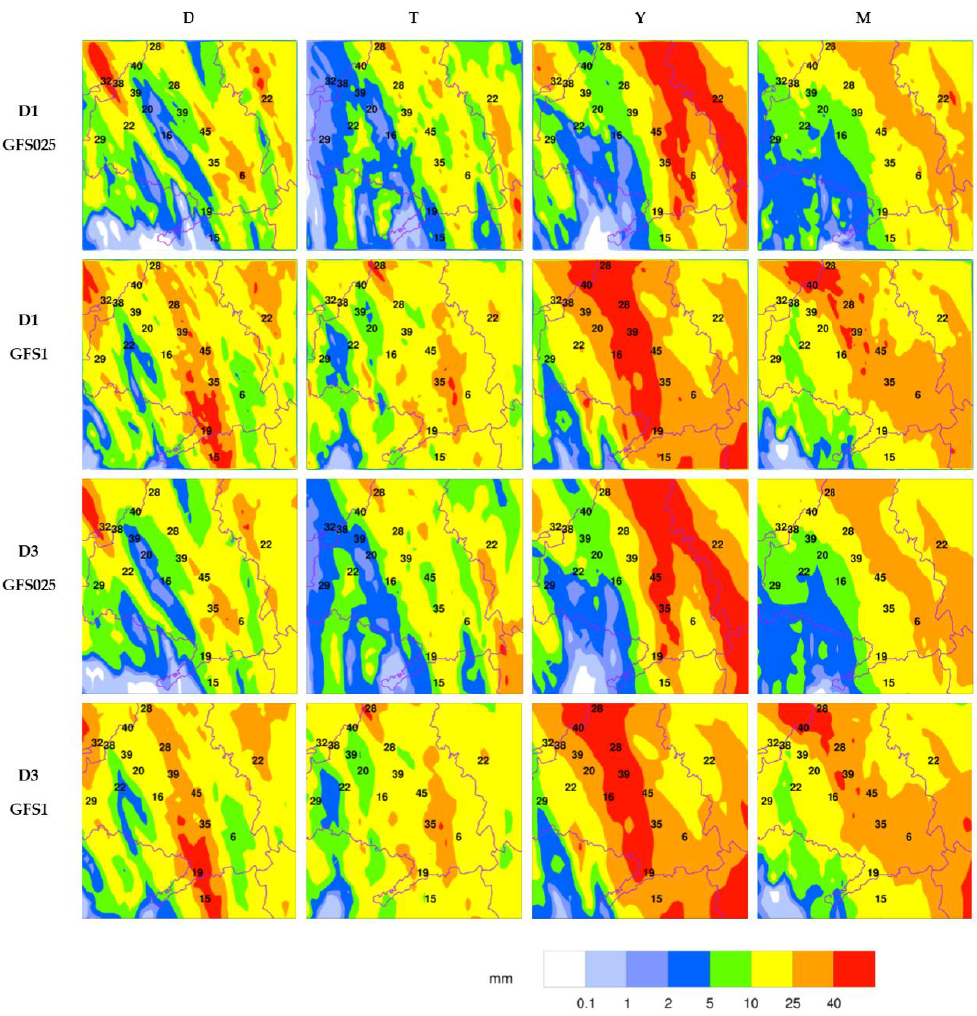
Figure 2. Accumulated precipitation (mm) between 10:00 and 18:00 UTC for GFS025 and GFS1, D1, and D3 deterministic model configurations. Observed accumulated precipitation (mm) for each station is shown at station locations. D3 figures are cropped to match D1.